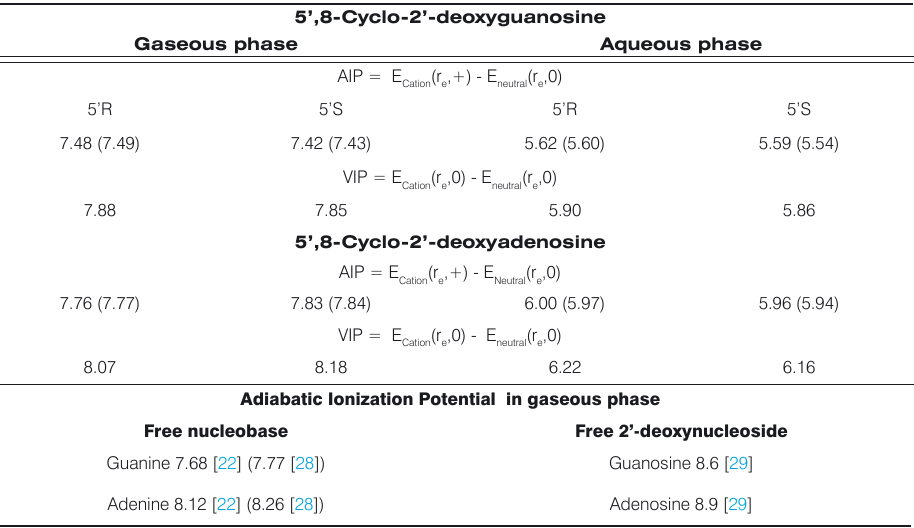
Table 1. Adiabatic Ionization Potential and Vertical Ionization Potential in eV of 5’,8-cyclo-2’-deoxynucleoside calculated by DFT B3LYP/6- 311++G**, values with ZPE are given in